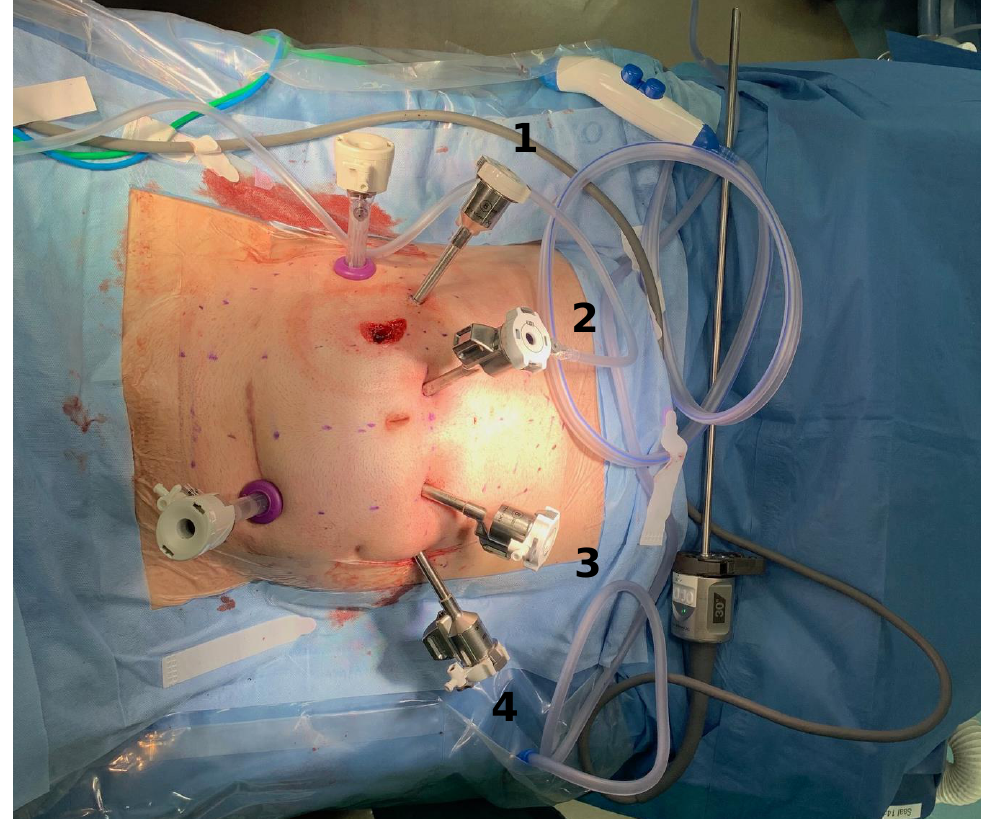
Figure 1. Placement of trocars after ileostomy takedown. Patient’s head, right side; patient’s legs, left side; arms 1–4, four 8 mm robotic trocars in a horizontal line, a few centimeters cephalad of the umbilicus; right flank, 12 mm auxiliary trocar; Pfannenstiel incision, 12 mm additional optical trocar for the conventional laparoscopic part of the operation.